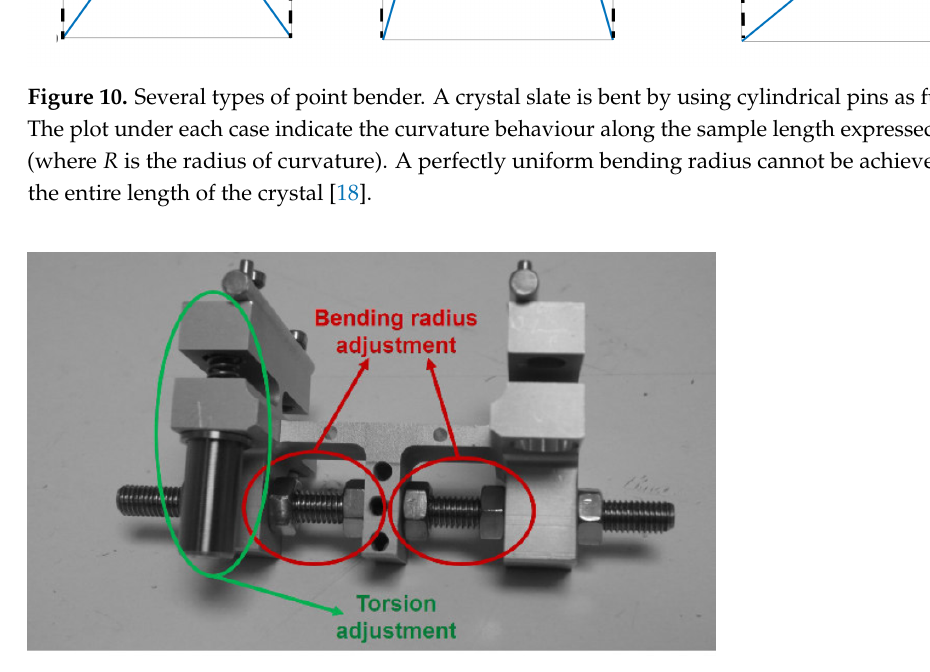
Figure 11. A metal holder for anticlastic bending. The crystal sample is clamped on the holder and the system of screws and bolts arch the holder forcing curvature on the sample. A second screw is used to deform the holder in orthogonal direction to the primary curvature in order to correct